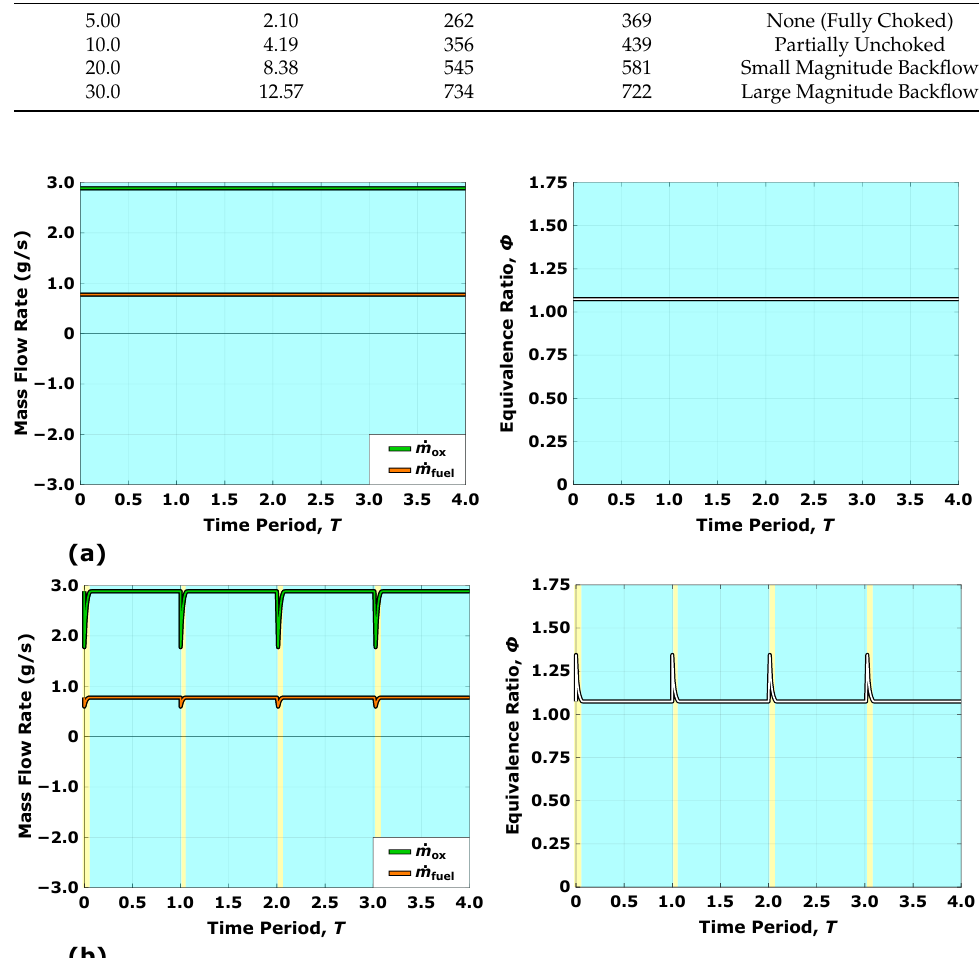
Figure 21. Temporal histories for the fuel and oxidizer mass flow rate ( left ) and corresponding equivalence ratio φ ( right ), for the ( a ) p rise = 5 and ( b ) p rise = 10 cases. Note that the cyan highlighted periods denote choked flow and yellow denotes unchoked